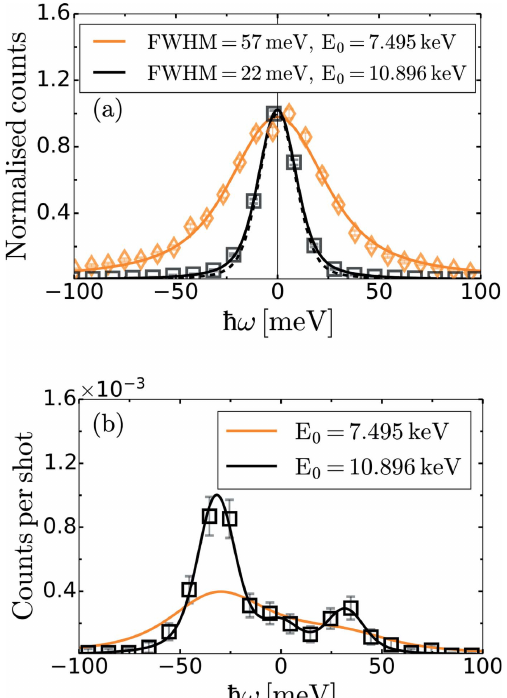
Figure 2 ( a ) Instrument functions measured on a 50 m m-thick PMMA sample at Q ’ 2 A˚ (cid:4) 1 using the (533) reflection of silicon at 7.5 keV (orange diamonds) and the (931) reflection of silicon at 10.9 keV (black squares). The solid lines correspond to the best fit to the data assuming a pseudo- Voigt lineshape and the black dashed line shows the simulated instrument function. ( b ) Inelastic spectrum measured from a 10 m m-thick Fe sample at ambient conditions (dark squares) to highlight the effect of the improved energy resolution. The solid black line corresponds to the best fit to the data using the model described by Descamps et al. (2020). The orange line corresponds to the spectrum one would expect using the energy resolution demonstrated at 7.5 keV. In both figures, each symbol corresponds to one pixel on the X-ray detector.